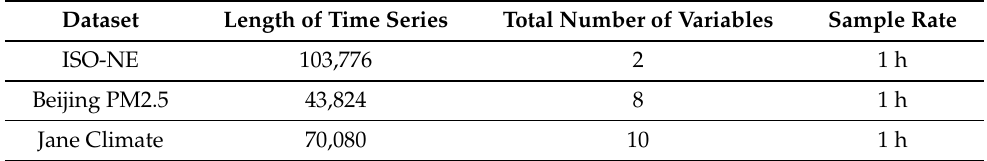
Table 1. Dataset